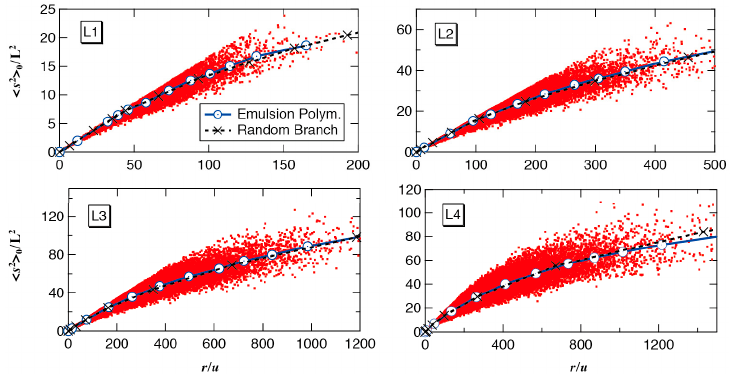
Figure 14. Relationship between the mean-square radius of gyration, < s 2 > 0 and the degree of polymerization, r for the living emulsion polymerization conditions, L1–L4. The red dots show the property of each polymer molecule simulated, and the blue curve with circular symbol is the expected < s 2 > 0 –value for the given r . The black dotted curve with × -symbol is for the random branched polymers, having the same primary chain length distribution and the average branching density. The black dotted curve with X-symbols shows the value of < s 2 > 0 / L 2 of the random branched polymers whose primary polymer chain length distribution, as well as the average branching density, is the same as the present model emulsion polymers. The mean-square radius of gyration of the random branched polymers was estimated by the MC simulation, in which the primary chains